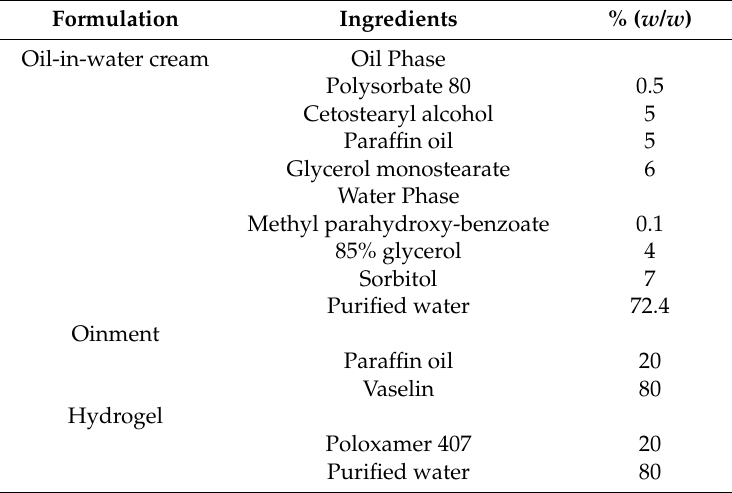
Table 3. Composition of the tested